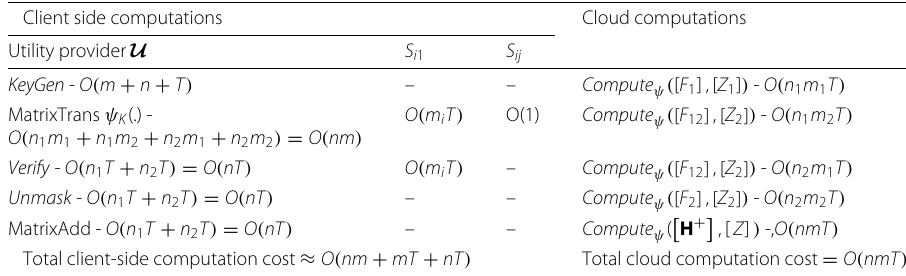
Table 6 Computation complexity analysis of the